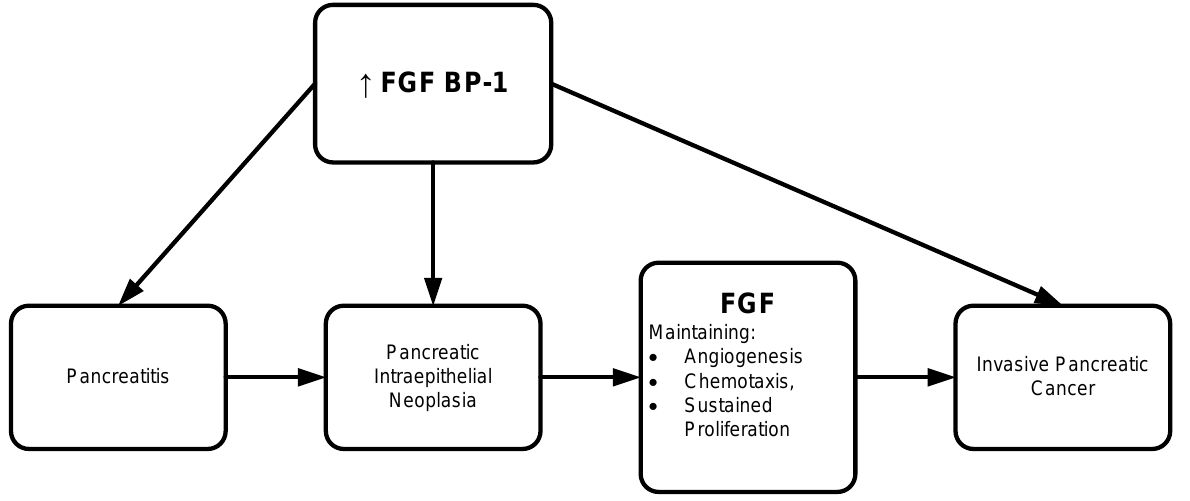
Figure 6. FGF-dependent regulation in transformation from pancreatitis to pancreatic intraepithelial neoplasia to invasive